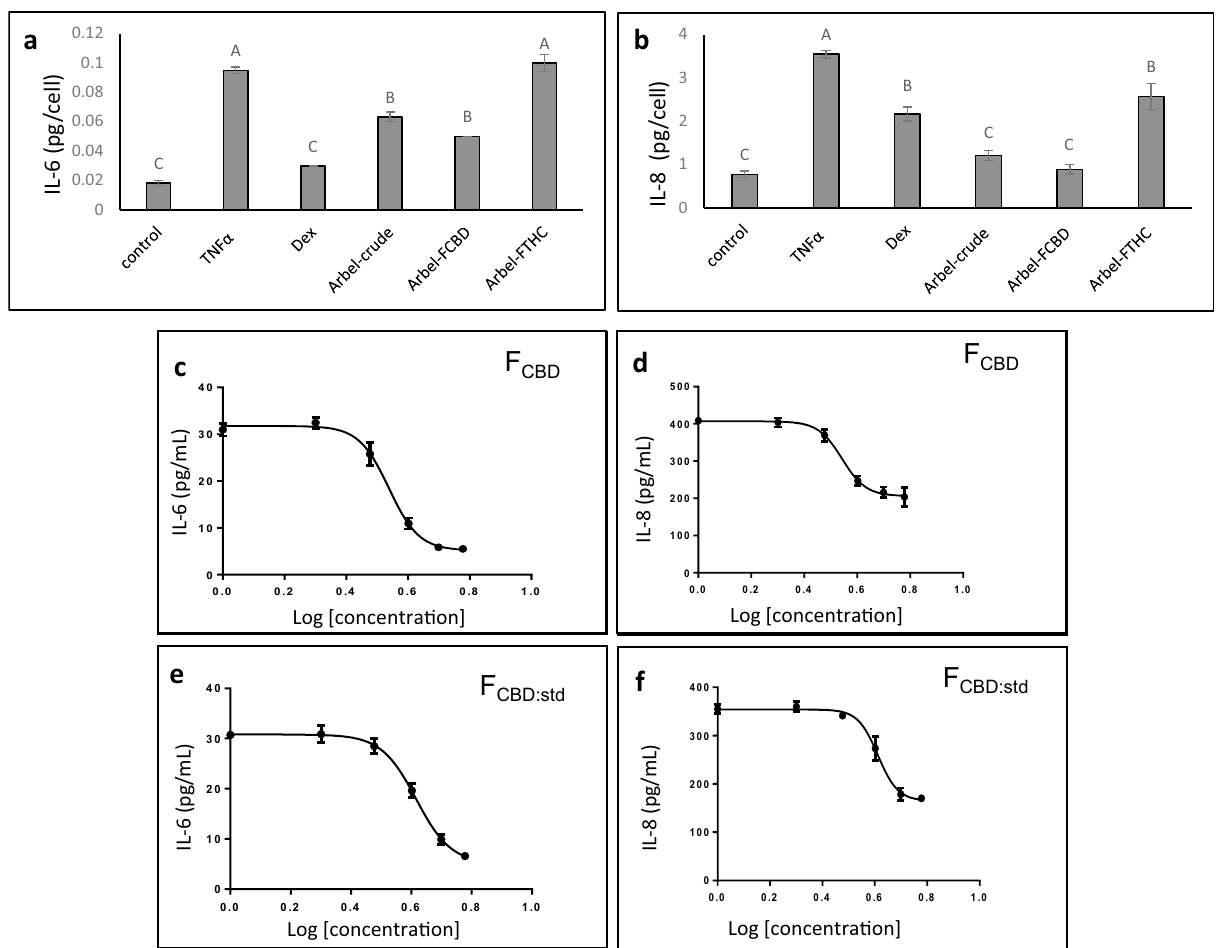
Figure 1. The levels of ( a ) IL-6 and ( b ) IL-8 in A549 cells treated with C. sativa Arbel crude and F CBD and F THC extract fractions. Cells were treated with 300 ng/mL TNFα and C. sativa extract and fractions at a concentration of 5 μg/mL for 4 h. Dexamethasone (Dex; 4 μg/mL) served as a positive control. Control (0.5% v/v methanol) treatment served as the solvent (vehicle) control; TNFα indicates TNFα+ solvent control treatment. Error bars indicate ± standard error (sem) (n = 3). Bars labeled with different letters are significantly different from all combinations of pairs by Tukey–Kramer honest significant difference test (HSD; P ≤ 0.05). Dose–effect curves of C. sativa F CBD on ( c ) IL-6 and ( d ) IL-8 levels in the A549 cell line. Dose–effect curves of F CBD:std (93.5% CBD+ 6.1% CBG+ 0.4% THCV) on ( e ) IL-6 and ( f ) IL-8 levels in the A549 cell line. GraphPad Prism version 6.1 was used to produce the dose–response curve and IC 50 doses. Error bars indicate ± sem (n =